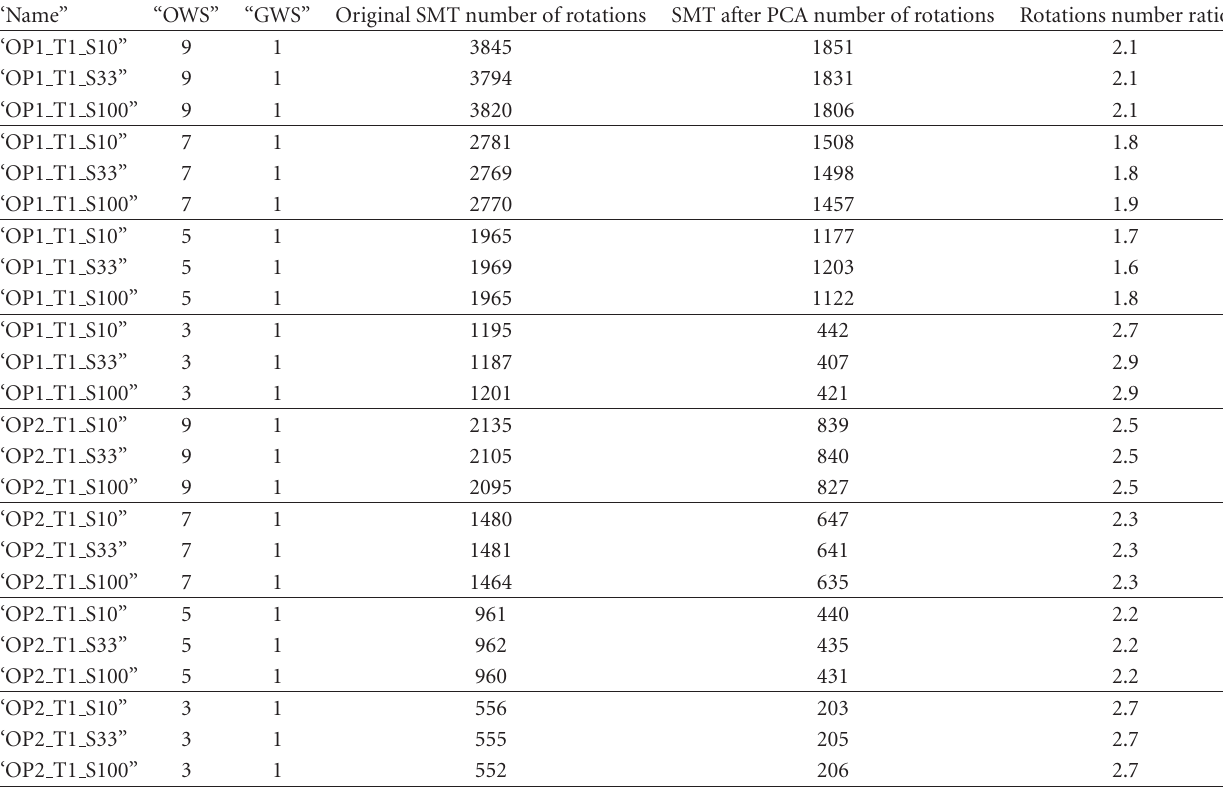
Table 3: This table shows the time it took to complete the calculation of a dataset.